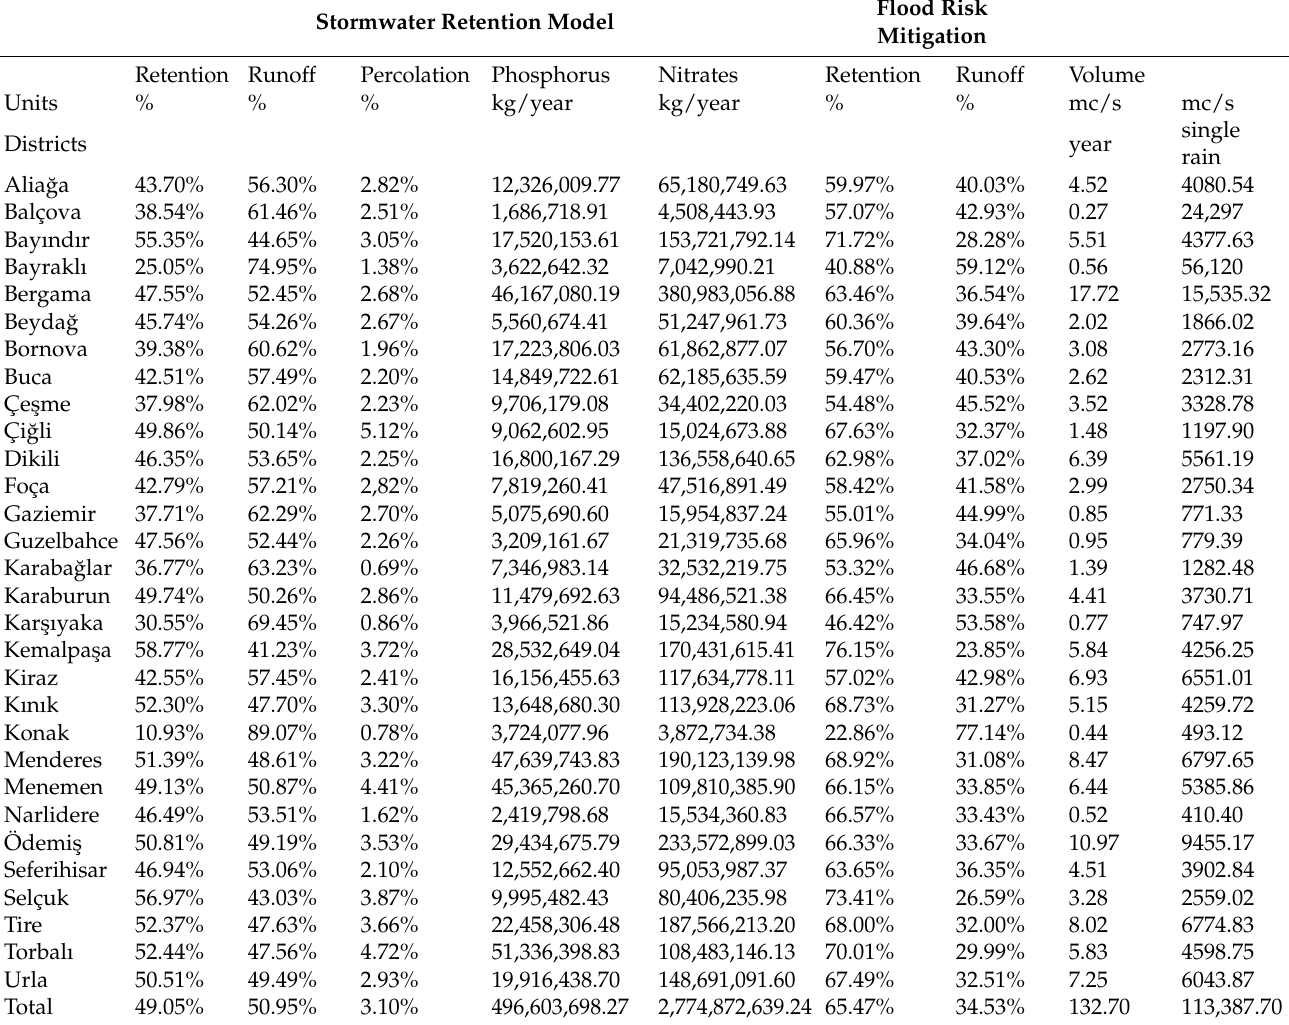
Table 5. Modeling results (absolute values). Source: InVEST